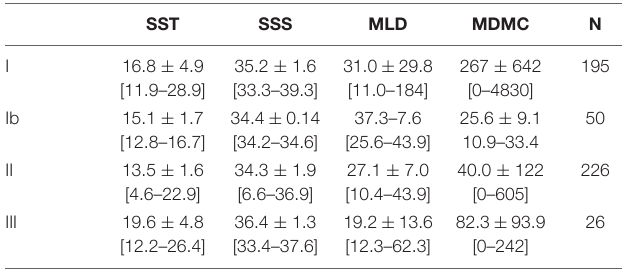
TABLE 4 | Mean reconstructed environmental characteristics for all strains for which cox haplogroup is available (from 1993). SST SSS MLD MDMC